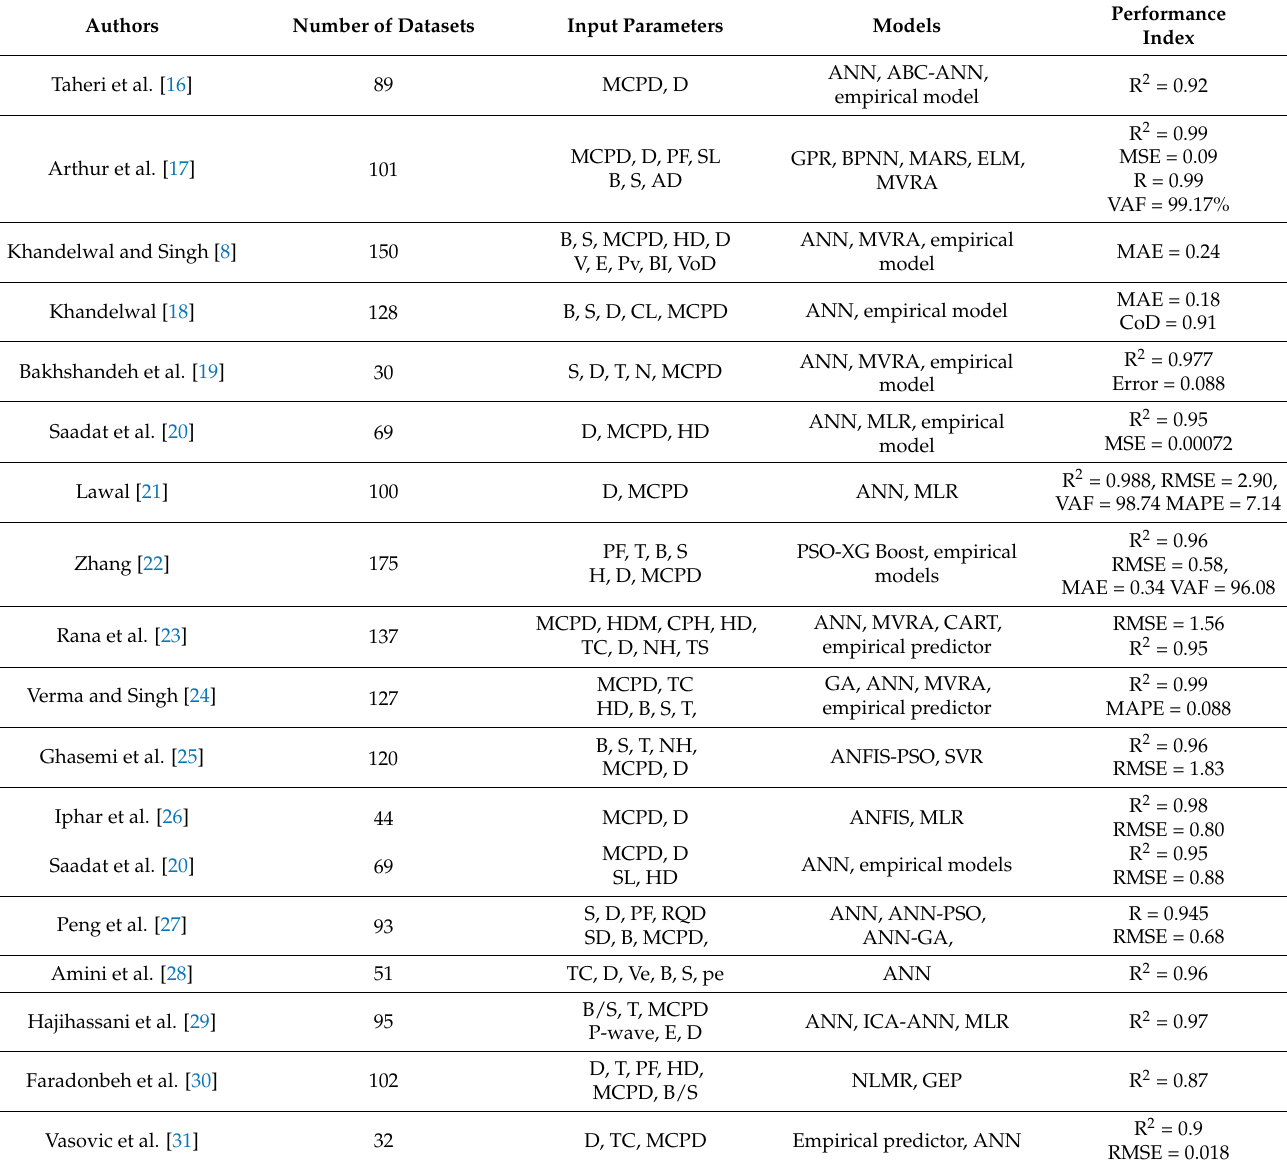
Table 1. Summary of selected previous studies that integrate artificial intelligence (AI) techniques for the prediction of blast-induced ground vibration. The table includes the models, input parameters, performance index, and number of datasets for each selected